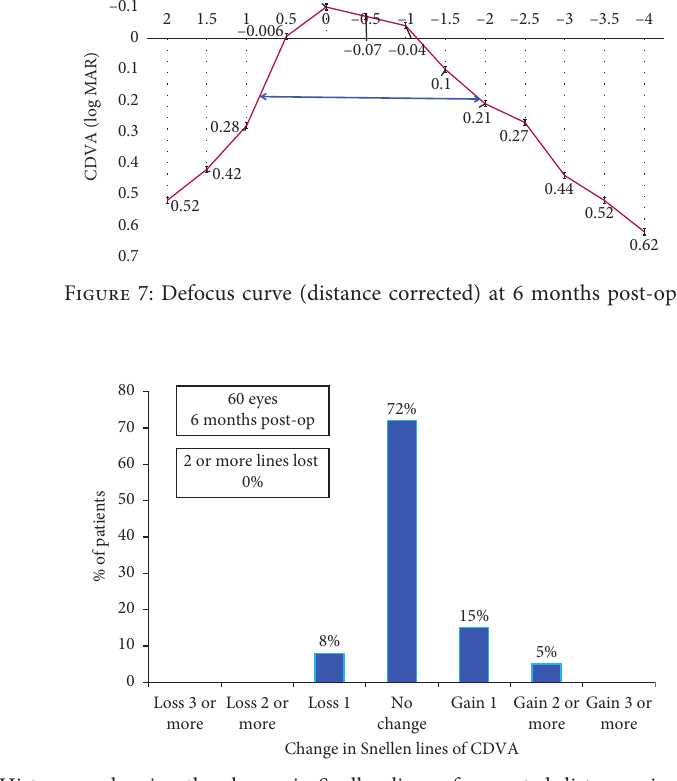
Figure 8: Histogram showing the change in Snellen lines of corrected distance visual acuity